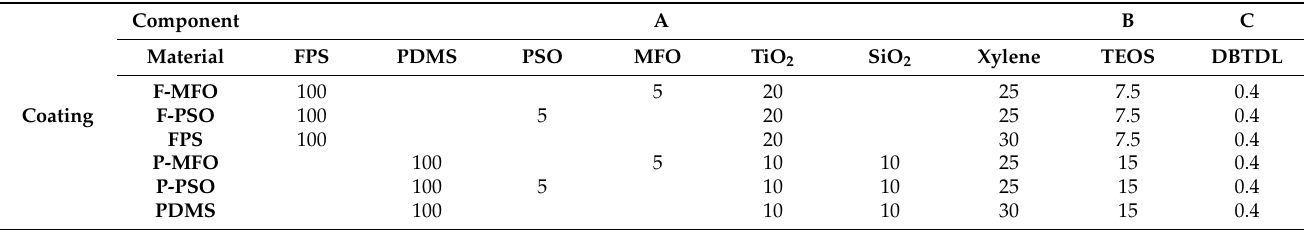
Table 1. Formulation of studied coatings